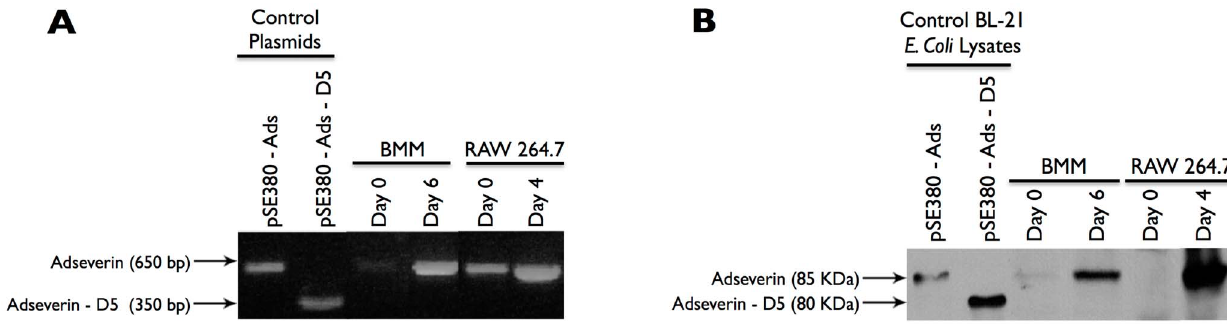
Figure 3. Adseverin D5 is not is expressed during invitro OCG. A ) PCR detected only the full-length Ads isoform in Day 0 and Day 6 BMMs and Day 0 and Day 4 RAW macrophage cultures. pSE380-Ads (full-length Ads) and pSE380-Ads-D5 (Ads D5 isoform) plasmids were used as positive controls. Equal volumes of cDNA from each representative samples were used as templates. The intensity of the signal is not a quantitative measure of Ads gene expression. B ) Immunoblot analysis also failed to detect the Ads D5 in BMM and RAW macrophage-derived osteoclasts. Lysates from the transformed BL21 E. coli induced to express exogenous protein were used as positive controls. Only the 85 kDa full-length isoform was detected in 20 m g of TCL from Day 6 BMMs and Day 4 RAW macrophages cultures. Ads was not detected in 20 m g of TCL from unstimulated samples.